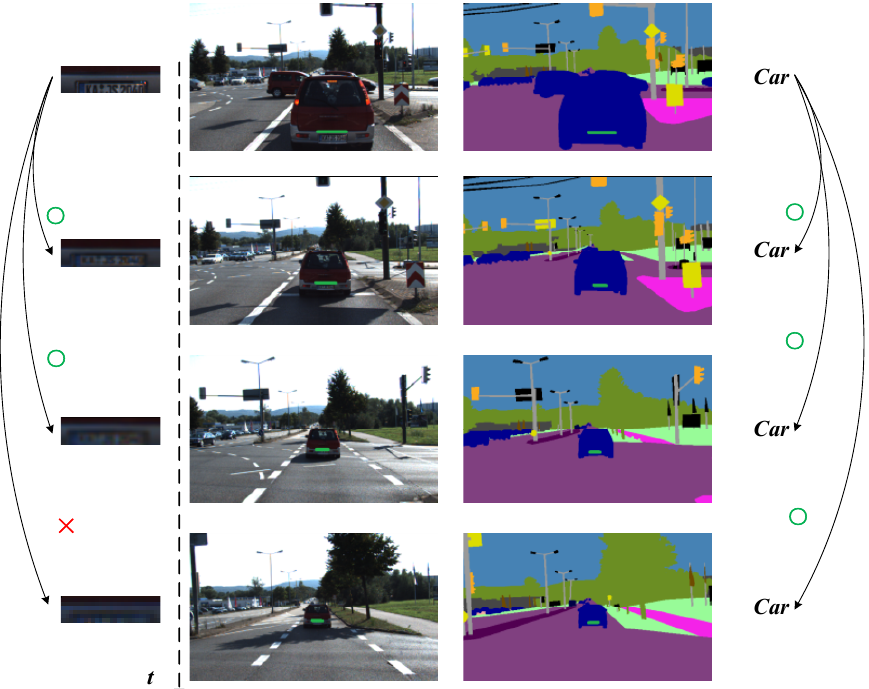
Figure 1. Description of feature semantic invariance. When the car is moving away, the pixels around the line segment change dramatically, but its semantic description remains unchanged.